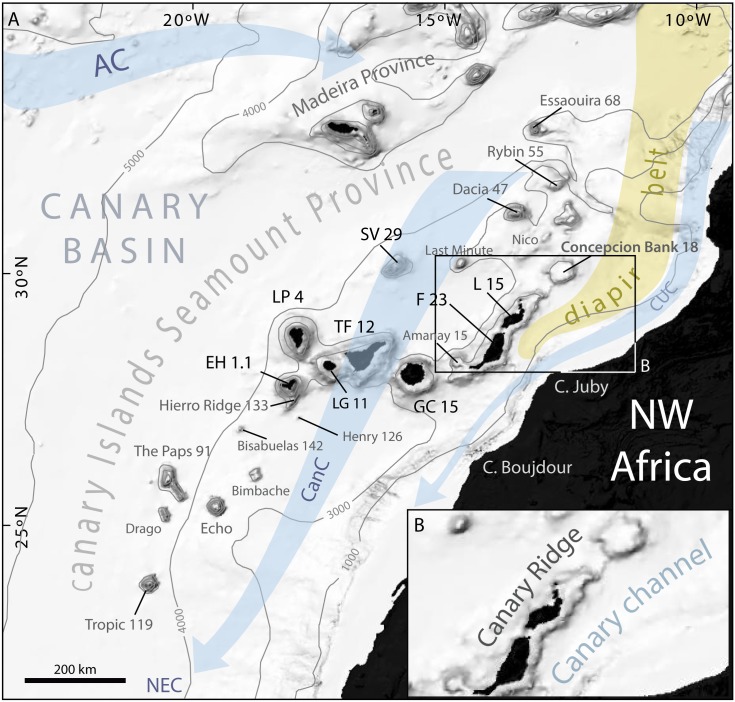
General bathymetric map of the Canary Islands Seamount Province (CISP).Note the seamounts, islands and other relevant physiographic features as well as the regional surface current system. The Canary Basin, the Canary Ridge, the Canary Channel and its diapir belt extending northwards are indicated. Numbers attached to seamounts and islands represent individual oldest age estimate where available, after Van den Bogaard [28]. AC: Azores Current. CC: Canary Current. CUC: Canary Upwelling Current. NEC: North EquatorialCurrent. SV: Selvagens. L: Lanzarote. F: Fuerteventura. GC: Gran Canaria. TF: Tenerife. LP: La Palma. EH: El Hierro. Bathymetry in meters from GEBCO.